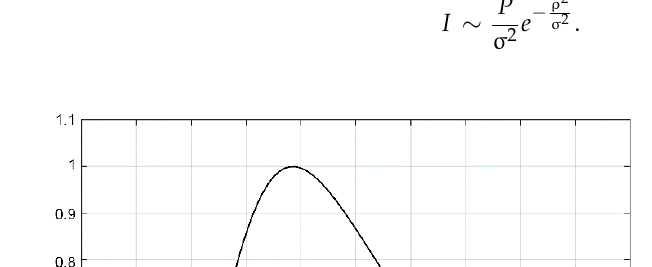
Figure 5. Dependence of the efficiency index of generation η of a radio vortex beam on the waist radius σ 0 of laser beams.